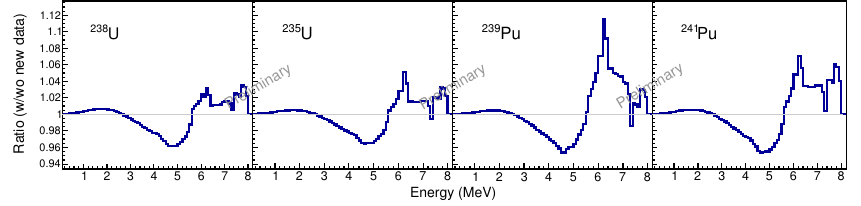
Figure 2. Ratios between 2 spectra built with the dataset described in the text over the same but the TAS